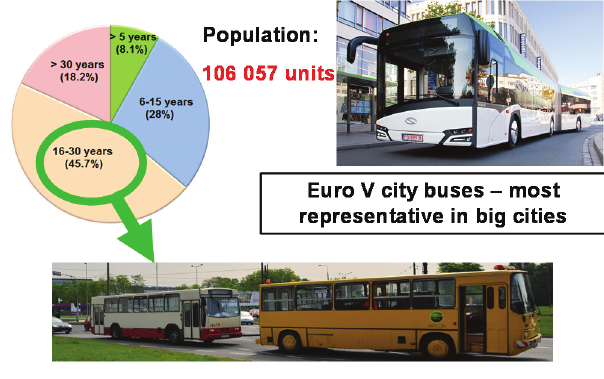
Fig. 22. Buses in Poland